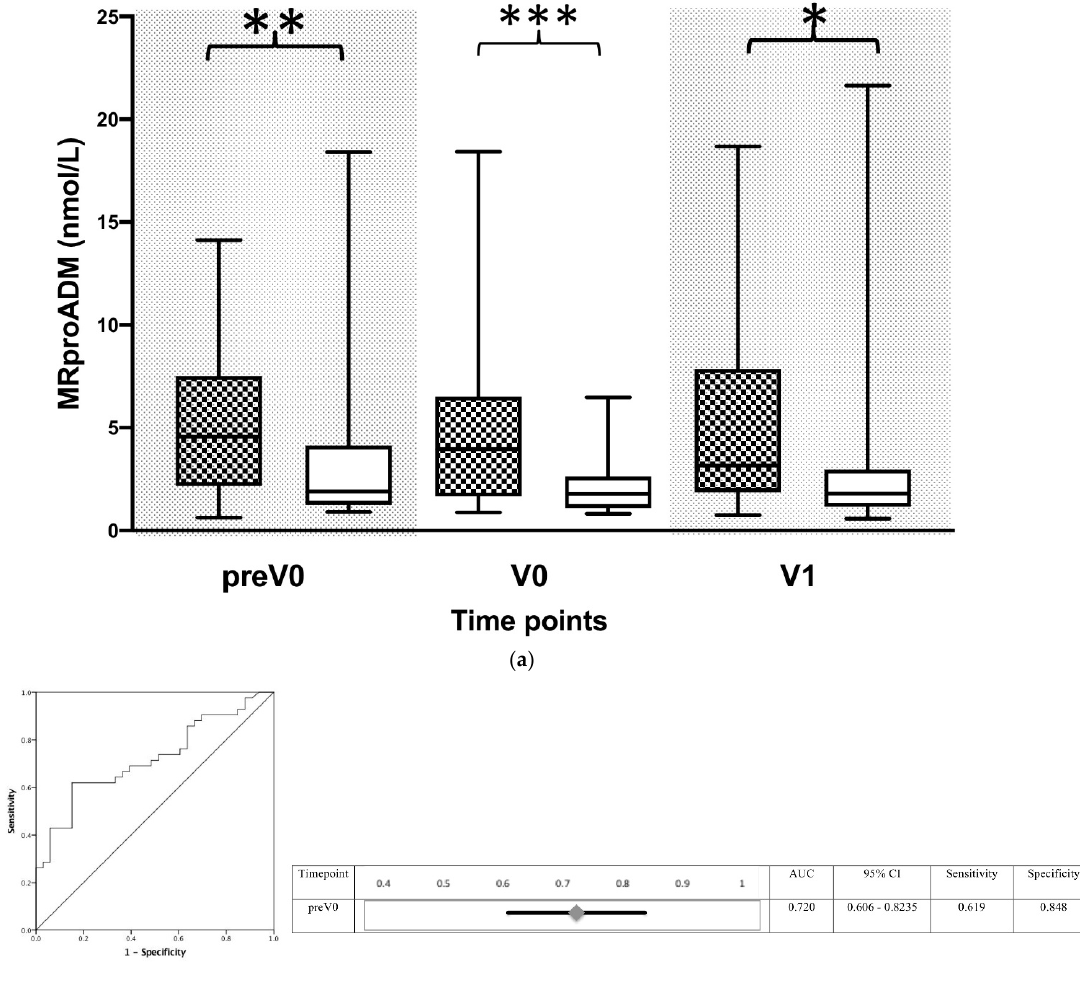
Figure 5. Plasma concentrations of mid-regional proadrenomedullin (MR-proADM) in patients following liver transplantation adjusted to the time of bacterial infection. ( a ) Plasma concentrations of MR-proADM were measured in patients following liver transplantation. Measurements in patients with bacterial infection were adjusted to the time of appearance (black squared box) and then compared to non-infected patients (white box). In patients with a bacterial infection, new timepoints were created by matching them to the first occurrence of bacterial infection, whereas the control group without bacterial infection was built by matching them in an age- and sex-related manner to the same timepoints as those for patients with bacterial infection. The following virtual timepoints were created: the first measurement before the first bacterial infection (preV0), the plasma level at the time of bacterial infection (V0) and the subsequent measured plasma level (V1). MR-proADM is presented in nmol/L. Data in box plots are given as the median, 25th percentile, and 75th percentile, with the 10th and 90th percentile at the end of the whiskers. Concerning symbolism and higher orders of significance: p < 0.05: *, p < 0.01: **, p < 0.001: ***. Mann–Whitney U Test. ( b ) Receiver operator characteristics (ROC)-analysis for MR-proADM in bacterial infected vs. uninfected patients regarding the virtual timepoint V0, described above. Abbreviations: AUC, area under the curve; CI, confidence